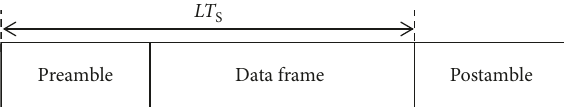
Figure 2: Frame format for Doppler estimation.